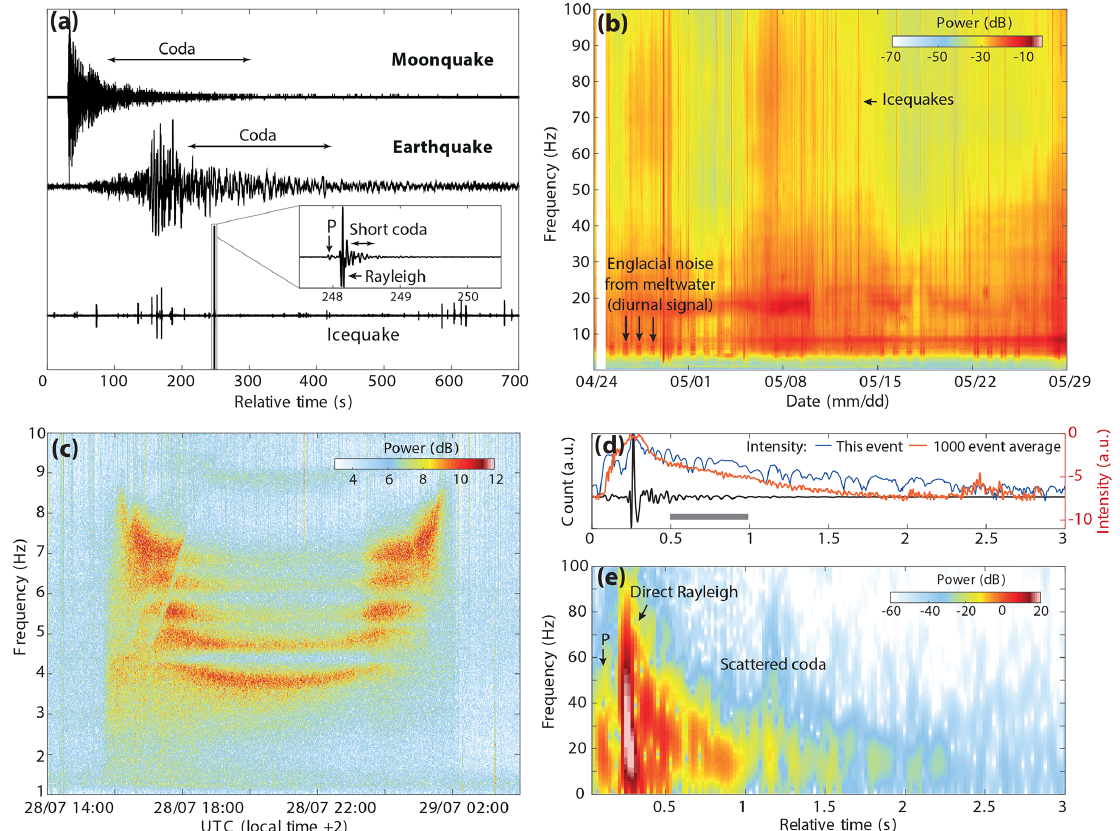
Figure 1. (a) Seismograms of a moonquake, regional earthquake, and typical Alpine glacier seismicity. Moonquake seismogram was recorded during the 1969–1977 Apollo passive seismic experiment (Nunn, 2017). Zoom on icequake waveform shows the lack of sustained coda in homogeneous ice when compared to other signals propagating in crustal rocks. (b) Spectrogram of 1 month of continuous recording at Glacier d’Argentière (French Alps) showing abundance of icequakes (5–100Hz) and englacial noise (2–30Hz) produced by turbulent meltwater flow. (c) Spectrogram for a 10h long hydraulic tremor produced by the water moulin activity within the Greenland Ice Sheet network (Fig. 2b). (d) Seismic waveform and associated spectrogram (e) for one icequake recorded at Gornergletscher (Swiss Alps). Color lines in (d) are the signal intensity (see main text, Sect. 5.1) for this event in blue and averaged over 1000 events in orange (right y axis; note the logarithmic scale). The horizontal gray bar indicates the coda window which is used to generate the first estimations of Green’s functions (Sect.